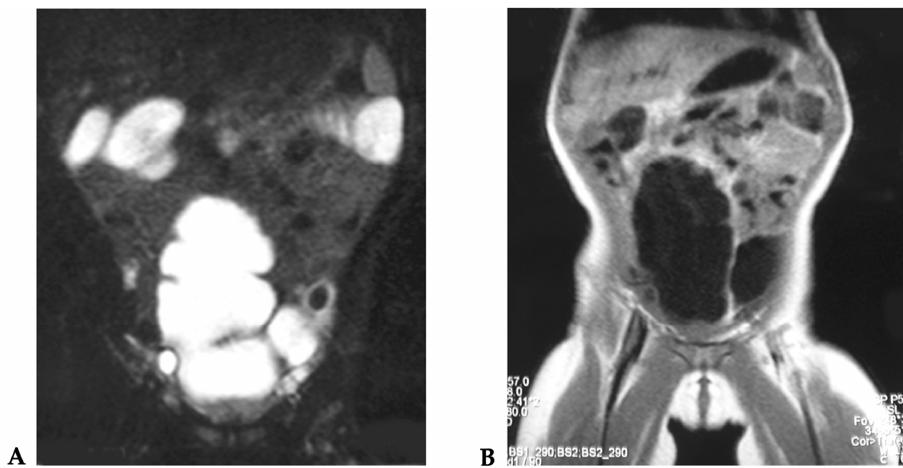
Figure 2. ( A , B ) MRI examination after surgical intervention.